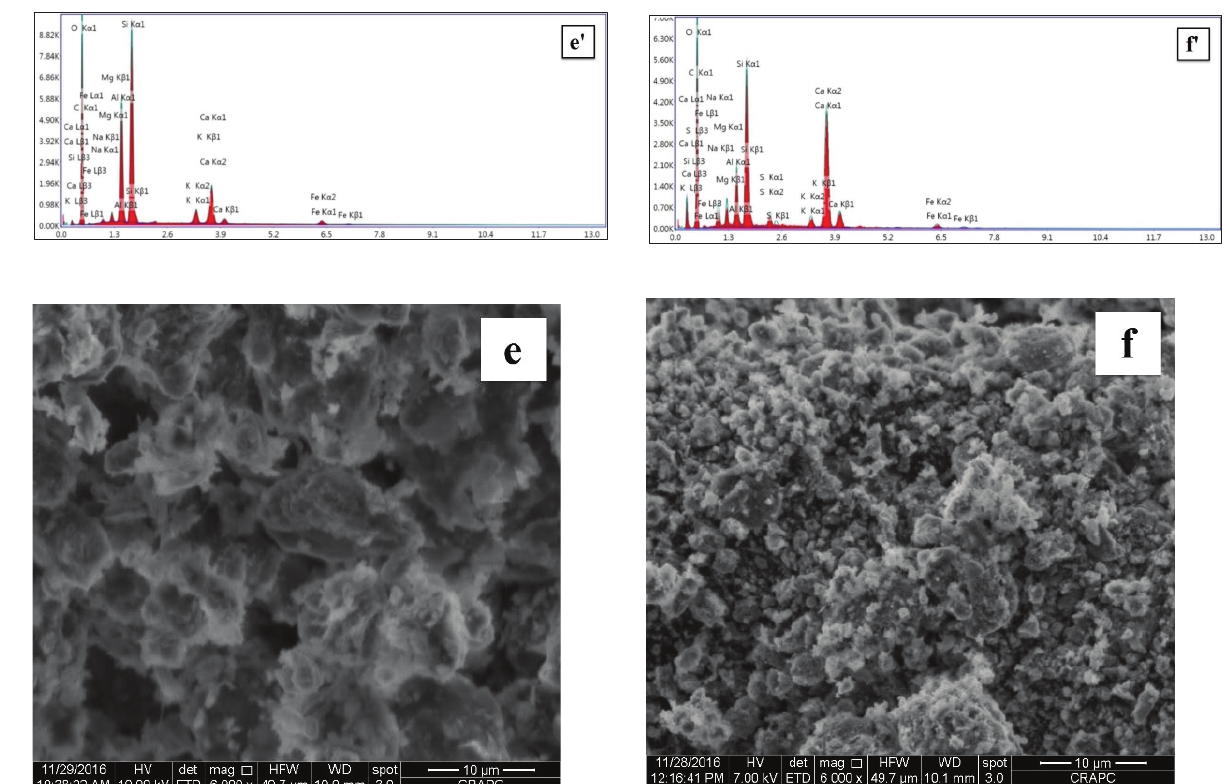
Figure 9: SEM and EDS analyses of soil treated with (8% bentonite+4% cement) and (6% bentonite+6%